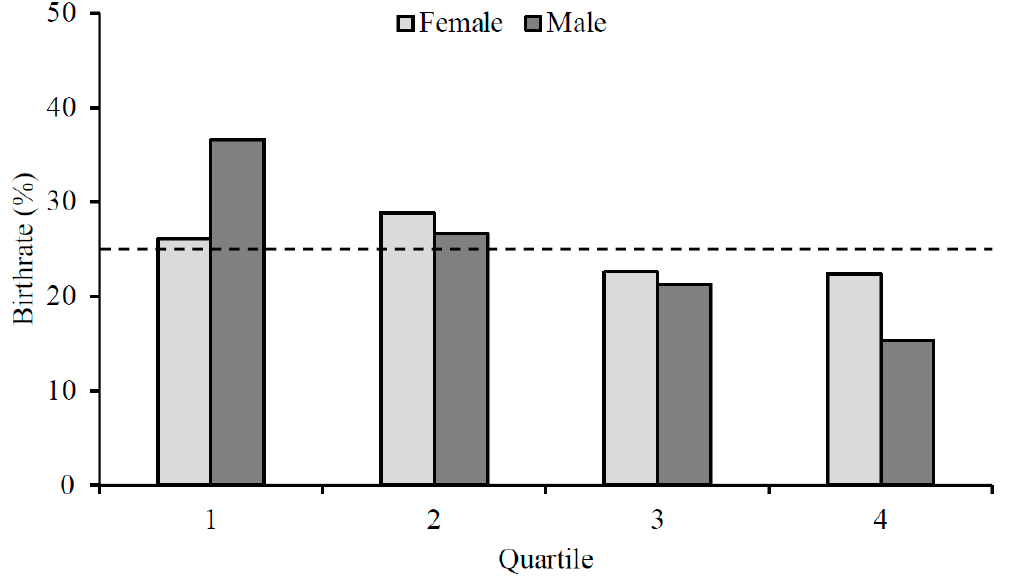
Figure 1. Birth quartile distribution for female (light grey) and male (dark grey) soccer players. The frequency and percentage distributions of players’ birth quartiles for competition level fication status, there were statistically significant RAEs for male [U17s: χ 2 = ( n = 1187) = 24.6, p < 0.001; U19s: χ 2 = ( n = 1229) = 15.7, p = 0.001; Senior: χ 2 = ( n = 1743) = 2.3, p = 0.506], but not female players [U17s: χ 2 = ( n = 324) = 1.5, p = 0.680; U19s: χ 2 = ( n = 293) = 4.8, p = 0.187; Senior: χ 2 = ( n = 1101) = 1.1, p = 0.788]. In male players, the chi-squared test